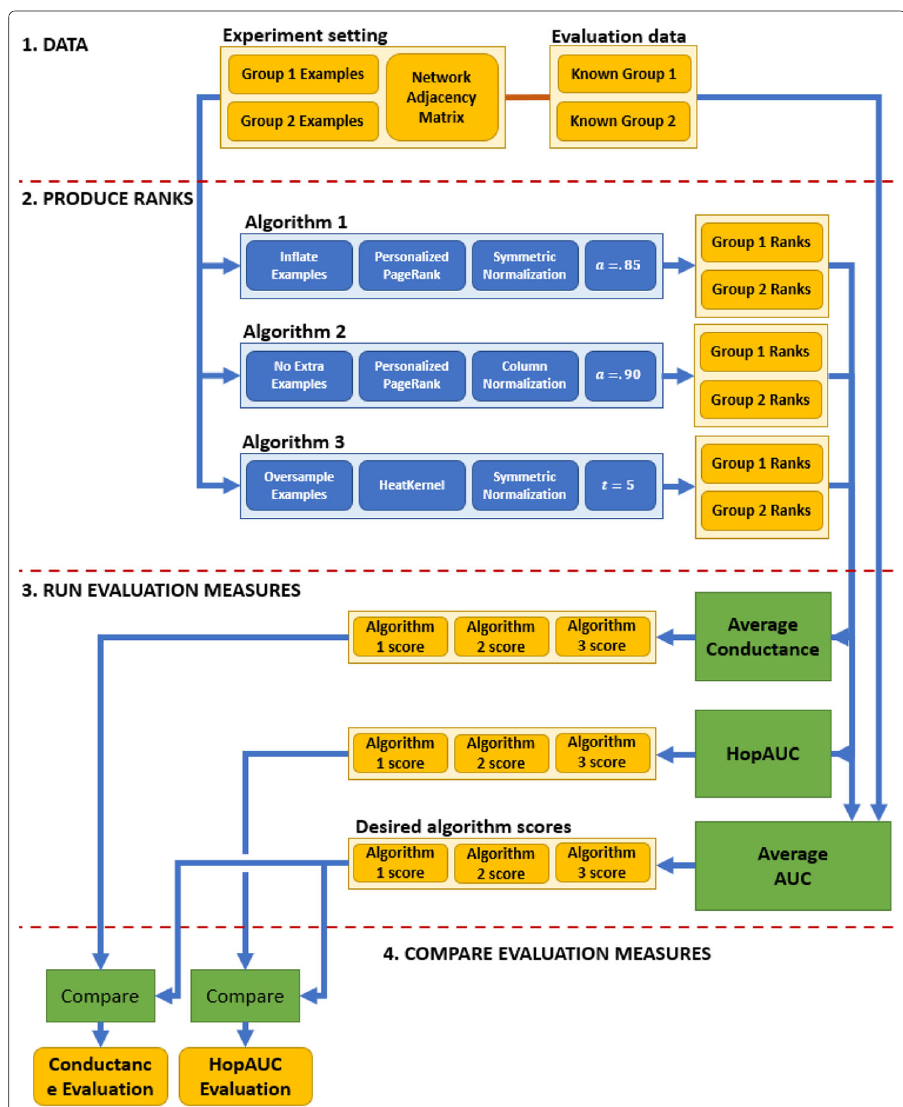
Fig. 8 Example of evaluating the ability of two unsupervised node rank quality measures (conductance and HopAUC) to compare three ranking algorithms in the same way as supervised AUC does. As a final step, we need to select the best of the unsupervised measures. Experiments in this work span 6 unsupervised evaluation measures, 72 ranking algorithms, are conducted for 25 experiments settings -which involve multiple metadata groups- and use both AUC and DCG for supervised comparison